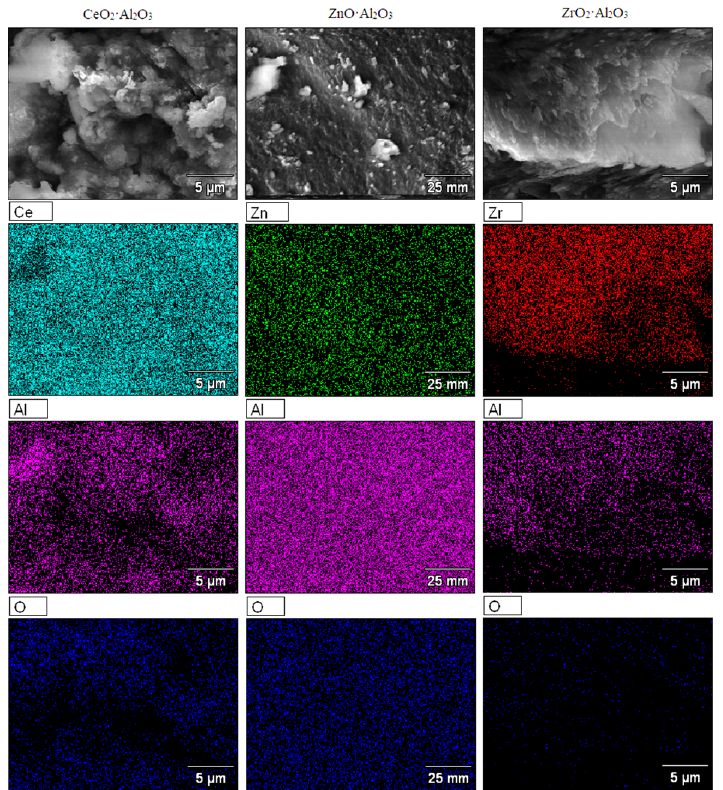
Figure 9. SEM images of calcined supports in an air atmosphere at 400 °C for 4 h.